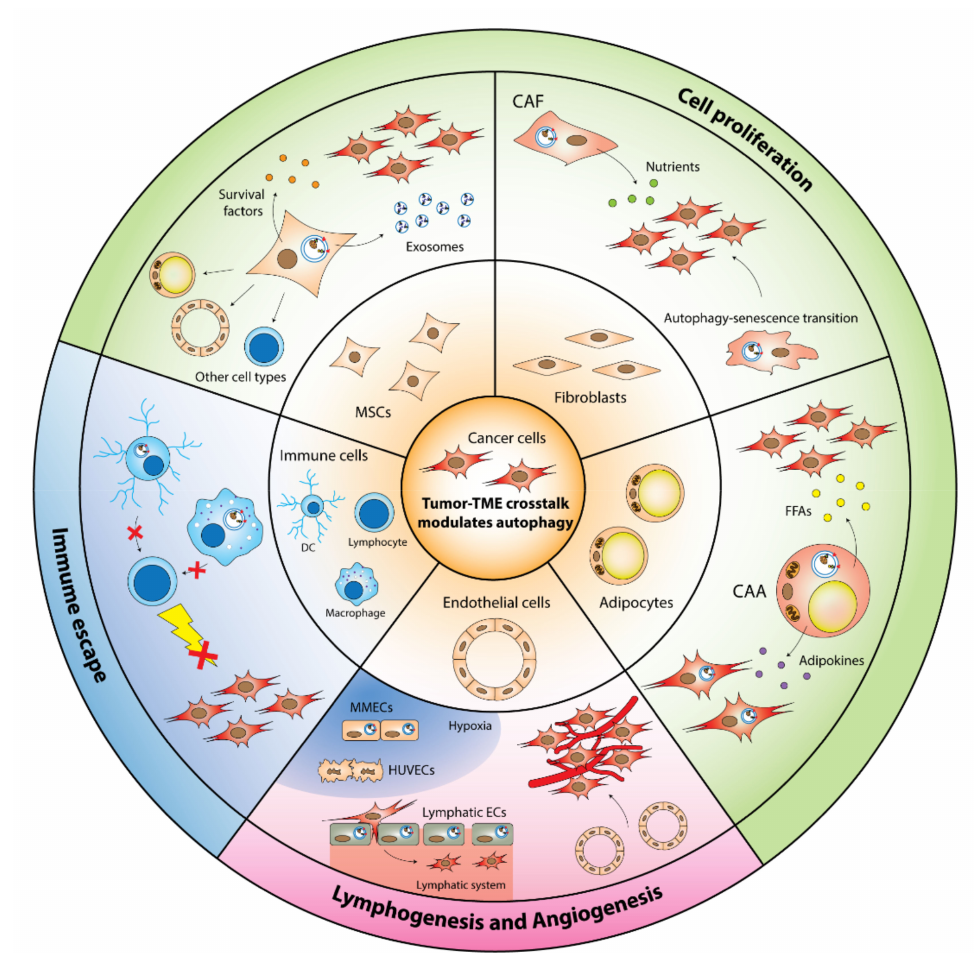
Figure 2. Autophagy in TME cells drives tumorigenesis. The activation or suppression of autophagy in the TME cells can reprogram their gene networks to modify the cells’ phenotypes, leading to disease progression through enhanced cell proliferation, modified lymphogenesis or angiogene- sis, and immune escape. CAA: Cancer-associated adipocyte; CAF: Cancer-associated fibroblast; DC: Dendritic cell; EC: Endothelial cell; FFA: Free fatty acid; HUVEC: Human umbilical vein en- dothelial cell; MMEC: multiple-myeloma endothelial cell; MSC: Mesenchymal stem